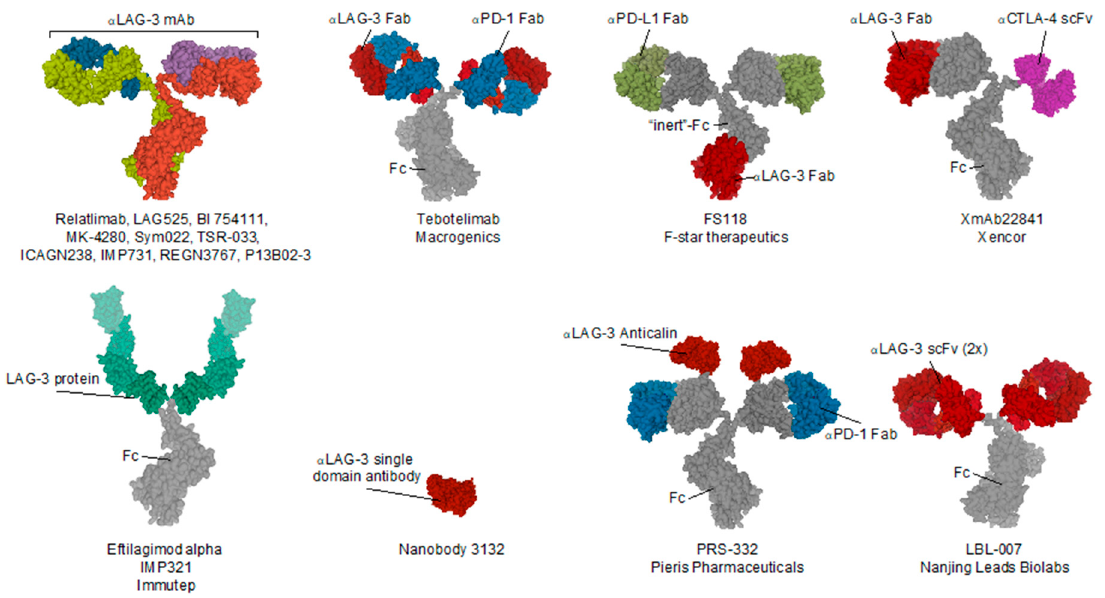
Figure 3. Schematic illustration of the structure and composition of LAG-3 targeting compounds evaluated as anti-cancer therapeutic and/or molecular imaging tracer. Abbreviations: Fab, antigen binding fragment; Fc, fragment crystallizable; scFv, single-chain variable fragment; α -LAG-3, anti-LAG-3.